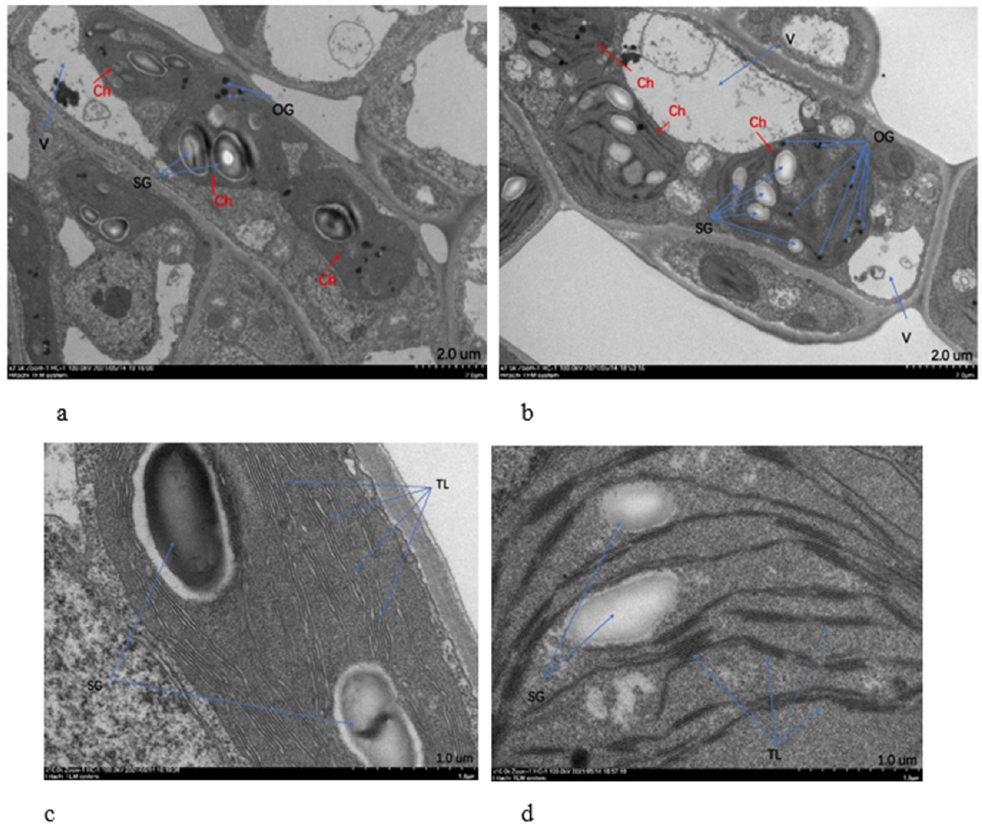
Figure 3. TEM images of P. tatarinowii ‘Jinyuyuan’. ( a ) TEM observation of cells in the green cells of leaves (GR). ( b ) TEM observation of yellow-green cells of leaves (YG). ( c ) Structure of the thylakoid lamellae in the green region of the leaf (GR). ( d ) Structure of the thylakoid lamellae in the yellow- green region of the leaf (YG). Ch: chloroplast, SG: starch granule, V: vacuole, OG: osmium granule, TL: thylakoid lamella.